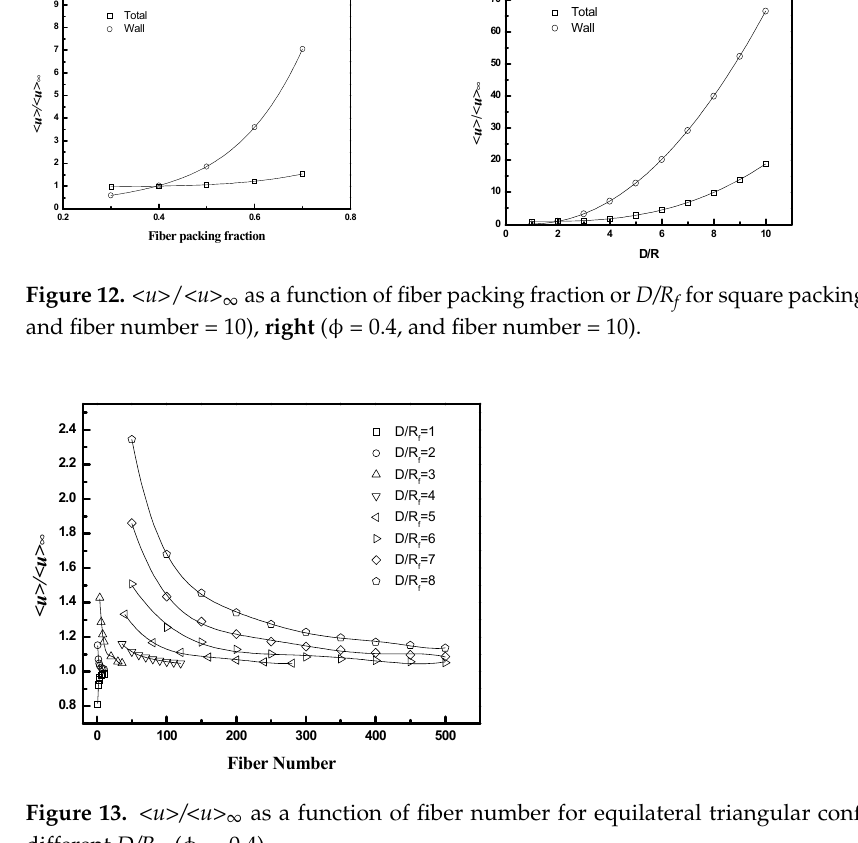
Figure 13. <u>/<u> ∞ as a function of fiber number for equilateral triangular configuration with different D/R f . ( φ =